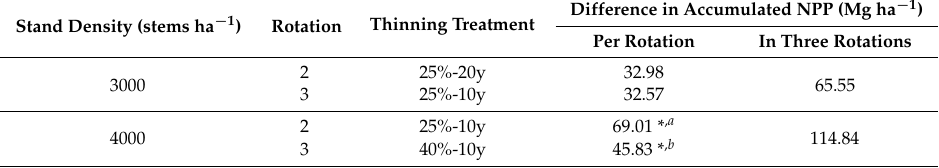
Table 3. Difference in accumulated NPP between optimal thinning and non-thinning treatments. Positive values mean accumulated NPP in a rotation increased due to management. * means average NPP under a thinning treatment in a rotation is significantly different from non-thinned ( p < 0.05), a means Welch’s Test, b means